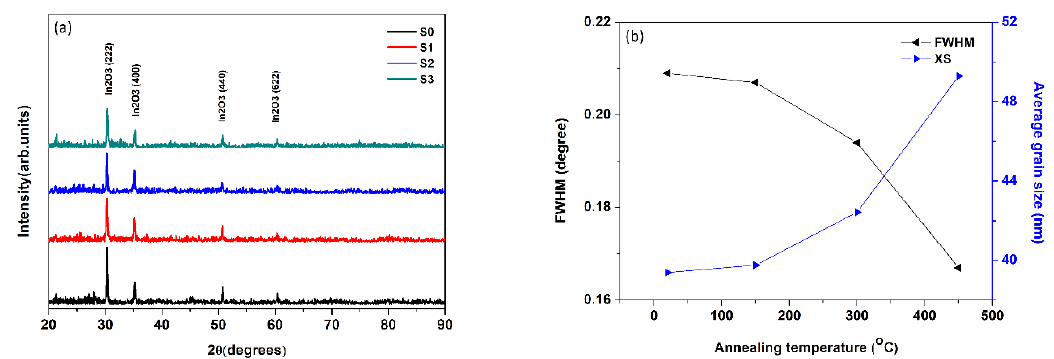
Figure 1. ( a ) The XRD intensities of as-deposited and as-annealed ITO films; ( b ) full-width at half-maximum (FWHM) and calculated average grain size of indium tin oxide (ITO) films as a function of annealing temperature in (222) crystallographic plane.